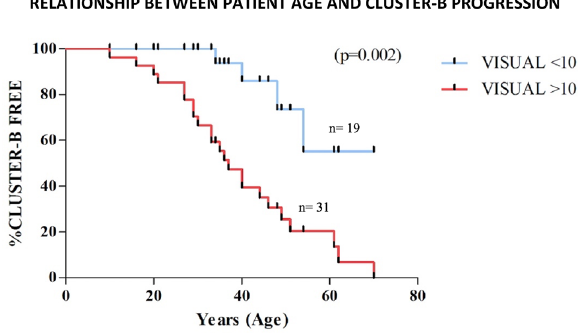
Figure 3. Relationship between patient age and development of complications (progression to Ameratunga’s Cluster B of severity) was assessed by Kaplan–Meier estimates for the VISUAL score. CVID patients with VISUAL ≥ 10 points progressed to cluster B faster than those with VISUAL < 10 ( p =